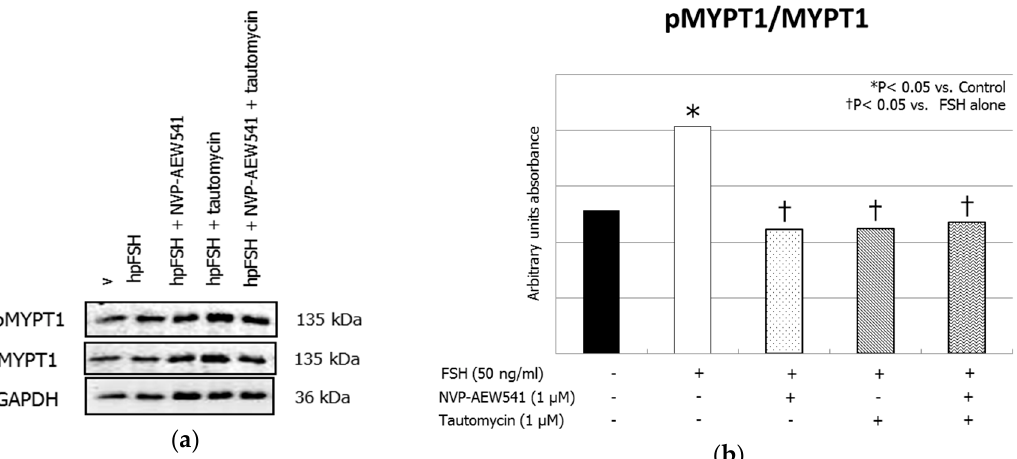
Figure 1. Insulin-like growth factor 1 receptor (IGF1R) is required for the Follicle-stimulating hormone (FSH)-induced myosin-phosphatase 1 (MYPT1) phosphorylation. ( a ) Immunoblots and ( b ) densitometric analysis of phosphorilated myosin-phosphatase 1 (pMYPT1), MYPT1 and Glyceraldehyde-3-Phosphate Dehydrogenase (GADPH) from Sertoli cells alone (control), or incubated with hpFSH alone or pre-treated with the IGF1R inhibitor NVP-AEW541 and / or protein phosphatase 1ß (PP1ß) inhibitor tautomycin and then incubated with hpFSH. Data represent the mean ± standard error of the mean (SEM) (* p < 0.05 vs. controls and † p < 0.05 vs. FSH treatment alone) (one-way ANOVA) of three independent experiments, each performed in